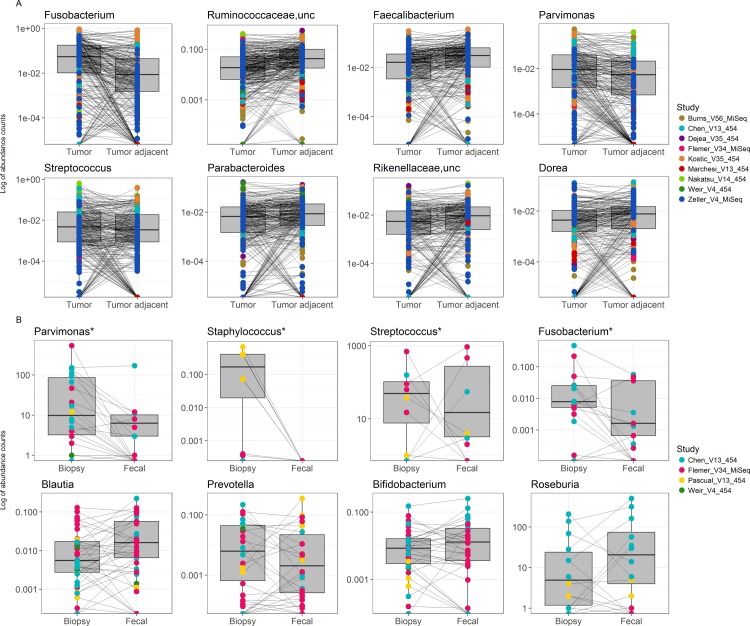
Pairwise differences in tumor vs. adjacent tissue and fecal vs.tumor biopsy samples.Boxplots indicate the distribution of the relative abundances of various taxa and corresponding lines connect paired samples, depicting the direction of change in relative abundance of statistically significantly different families between CRC tumor biopsy samples (left) and adjacent non-affected tissue microbiome (Fig 2A, n = 294 pairs, 588 samples) or fecal sample (Fig 2B, n = 42 pairs, n = 84 samples) for the various studies (colors) * indicates mean relative abundance was statistically significantly different between the genera by paired Wilcoxon signed rank test and p<0.05 after FDR adjustment. All biopsy-based taxa presented in Fig 2A were statistically significantly different between tumor and tumor biopsy samples by above mentioned test.